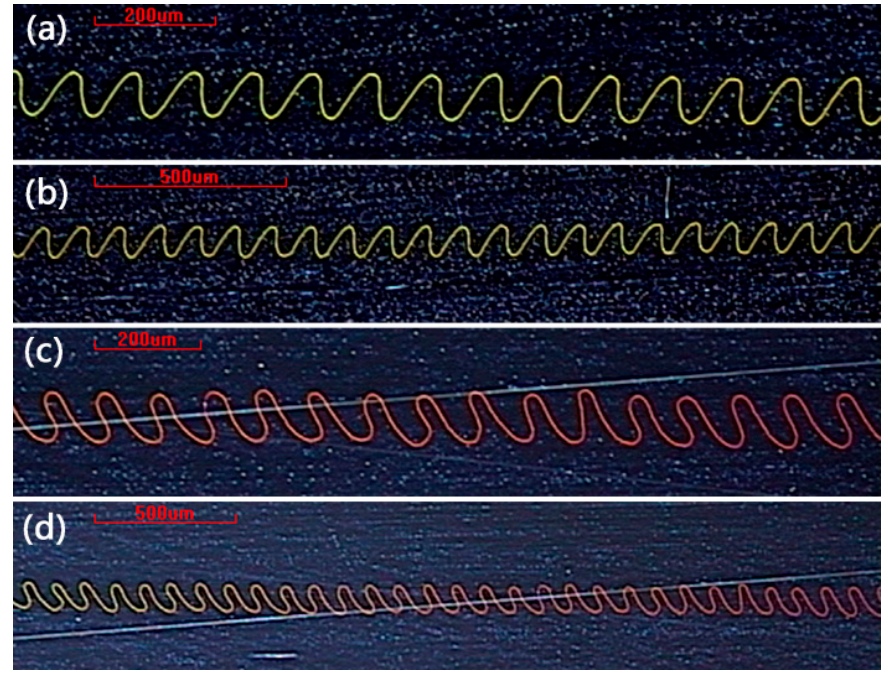
Figure 5. The typical lopsided patterns direct-write with the help of an AC electric field not perpendicular to the velocity of collector. DC voltage 1.3 kV, AC voltage 300 V, 50 Hz, nozzle-to-substrate distance 5 mm, 8% PEO.